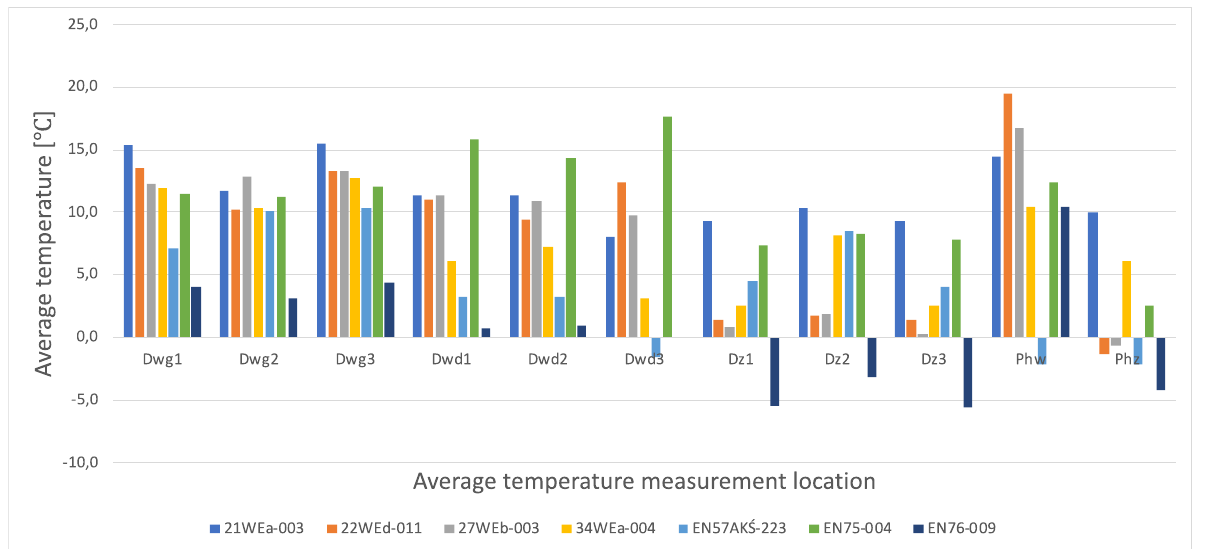
Figure 11. Graphical interpretation of the average component temperatures of the various types of railway vehicles, where: Dwg1.2.3 − the places for measuring the inside of the door in the upper part; Dwd1.2.3 − the places for measuring the inside of the door at the in the bottom par; Dz1.2.3 — door measuring places from the outside; Phw − place of measurement of the interconnection from inside; Phz − the place of measuring the interconnection from outside.